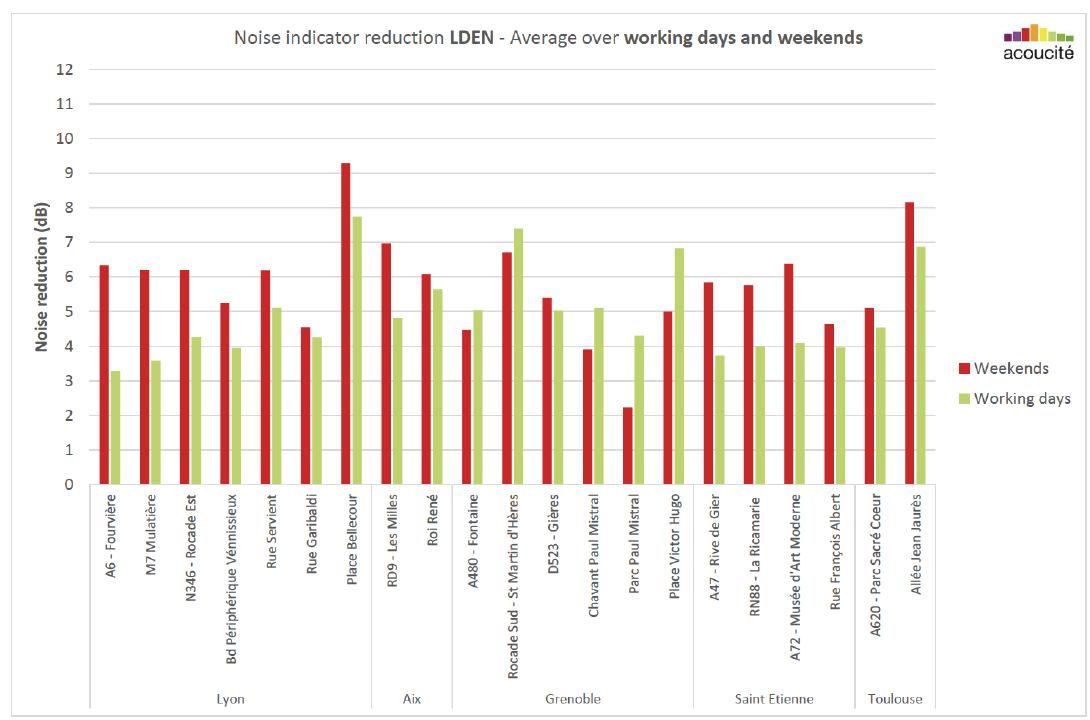
Figure 4: Reduction observed for working days and weekends for the 21 measuring stations. Difference between the average sound level in “normal situation” and the average sound level during lockdown